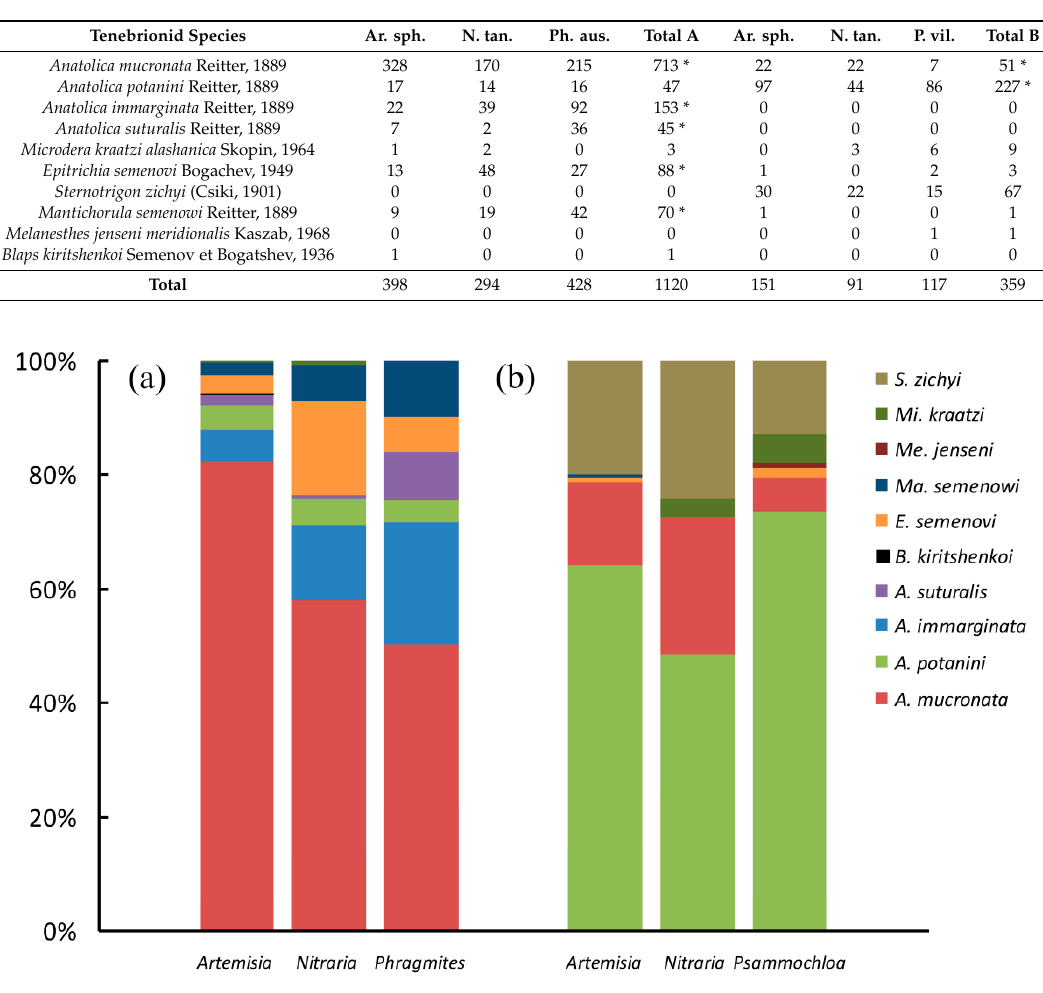
Figure 3. Proportion of the tenebrionid beetle species collected beneath four plant species in two sites (A and B, panels a and b, respectively) in the Ulan Buh Desert (Gobi Desert, Inner Mongolia, China). For insect species names, see Table 1.